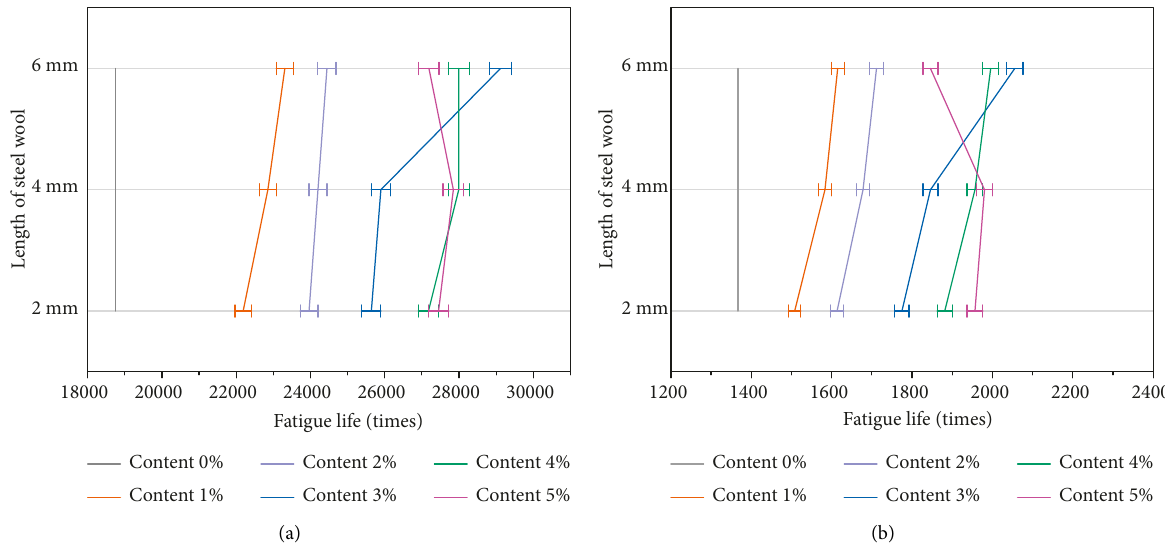
Figure 5: Fatigue performance of steel wool asphalt mixture. (a) Stress ratio 0.3. (b) Stress ratio